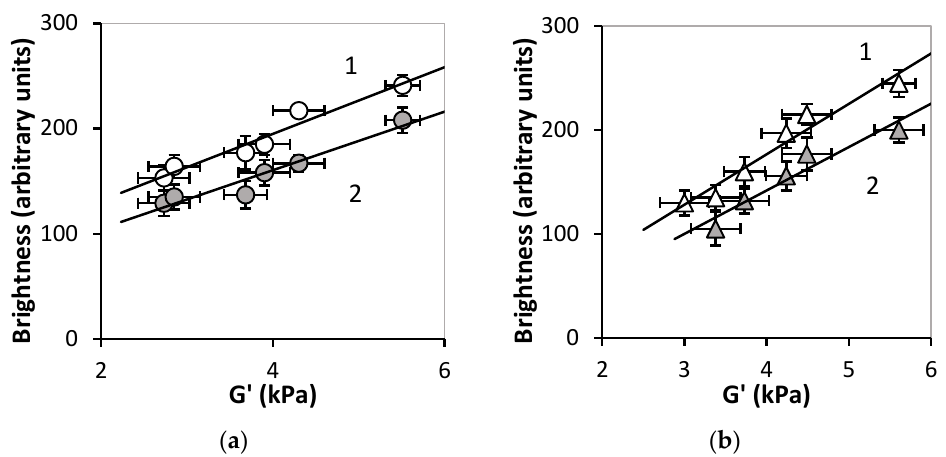
Figure 11. Dependences of the maximum (1) and average (2) brightness on the storage modulus for PAAm/Xanthan ( a ) and PAAm/Guar ( b ). Linear regressions: ( a ) I max = 31.7 G ' + 68.1 (R 2 = 0.946), I av = 27.8 G ' + 49.2 (R 2 = 0.930); ( b ) I max = 48.5 G ' − 17.1 (R 2 = 0.950), I av = 41.7 G ' − 25 (R 2 = 0.921).